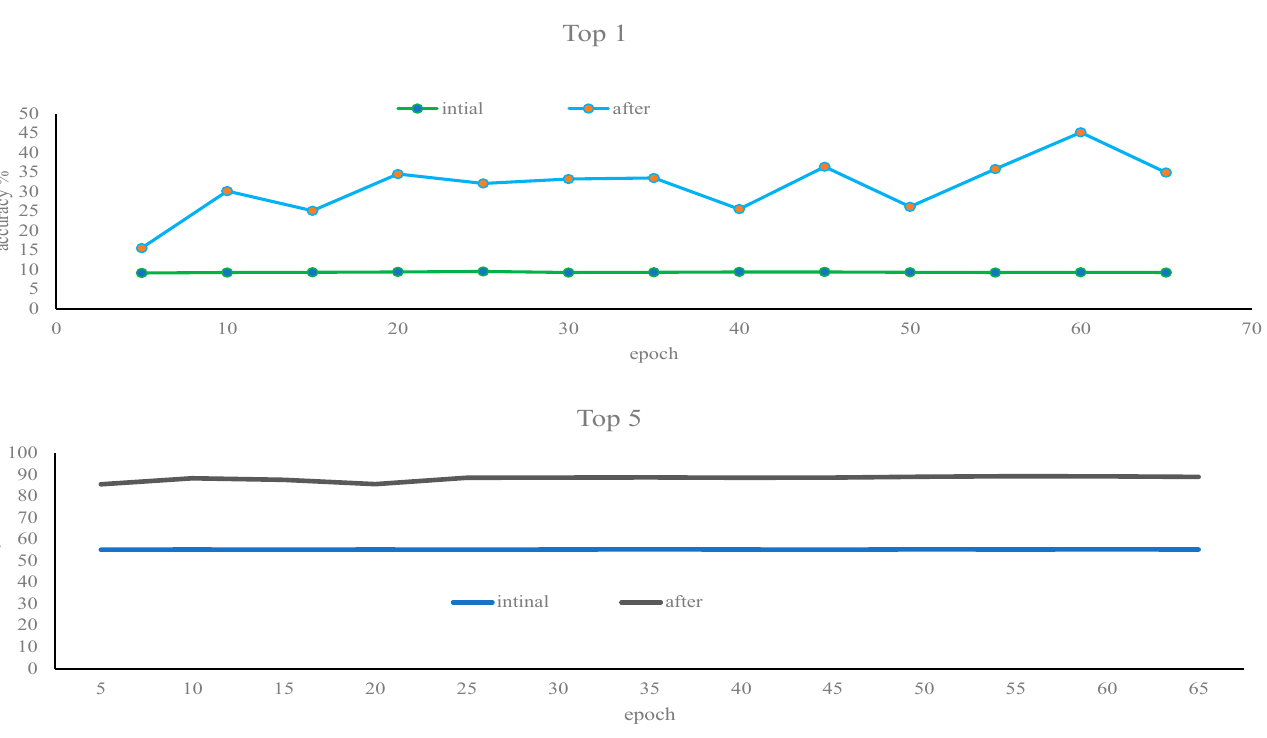
Figure 8. The comparison chart of the initial and modified recognition rates of Top1 and Top5.